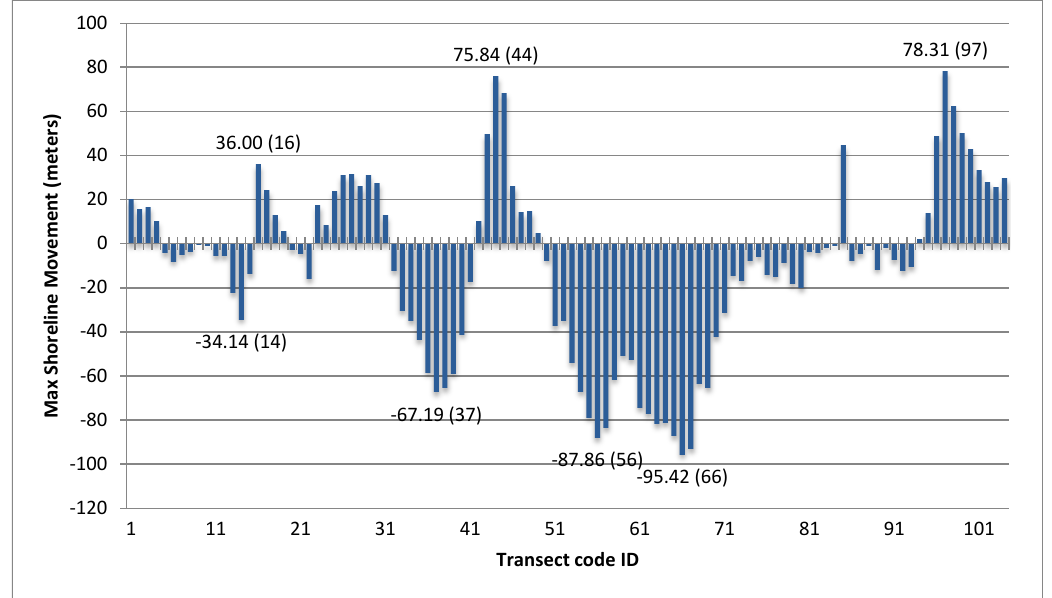
Figure 3. The minimum and maximum shoreline movement observed at each one of the 104 transects (with four observations), throughout the time period between 1945 and 2011. The first transection (code ID 1) corresponds to transect number 172, whilst the last one (code ID 104) to the transect 275 (see Figure 4 for locations). Several segments of large movements can be identified showing either pro-gradation (positive y-values) or retro-gradation (negative y-values)